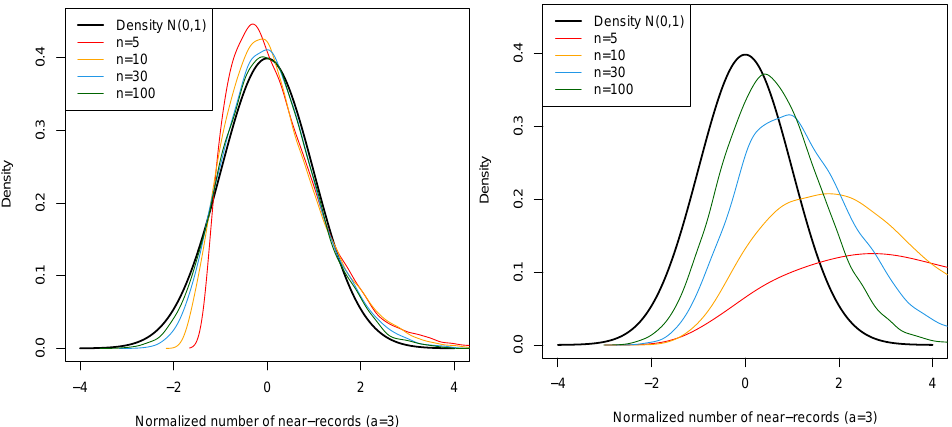
Figure 2. Smoothed histograms for simulated values of the normalised sequences η ( n ) , given in (45) and (47), with a = 3, different n values and 10 5 runs for each setting. Left panel: Geometric distribution with parameter p = 0.5. Right panel: Poisson distribution with rate λ =